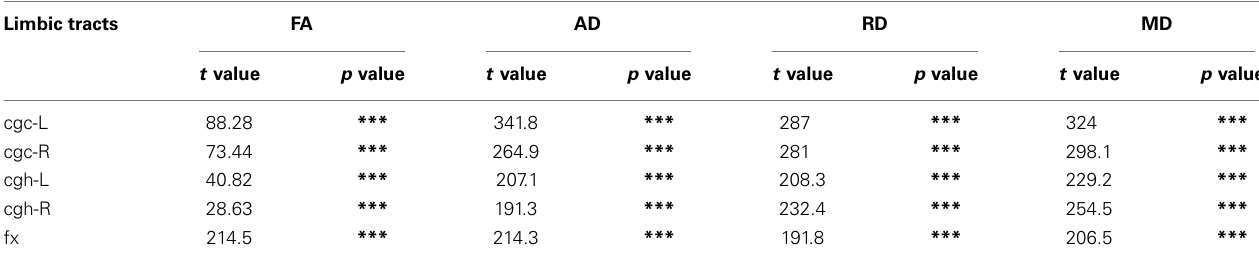
Table 5 | Comparisons of DTI metrics of limbic tract before and after FWE correction with age and gender as covariates . Limbic tracts